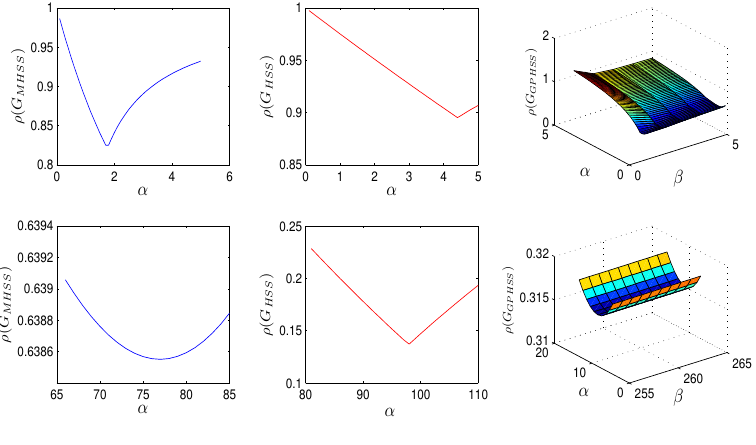
Figure 2. The spectral radius versus parameter α for HSS and MHSS methods and parameters α , β for GPMHSS method; Top : Example 4.1 and Bottom : Example